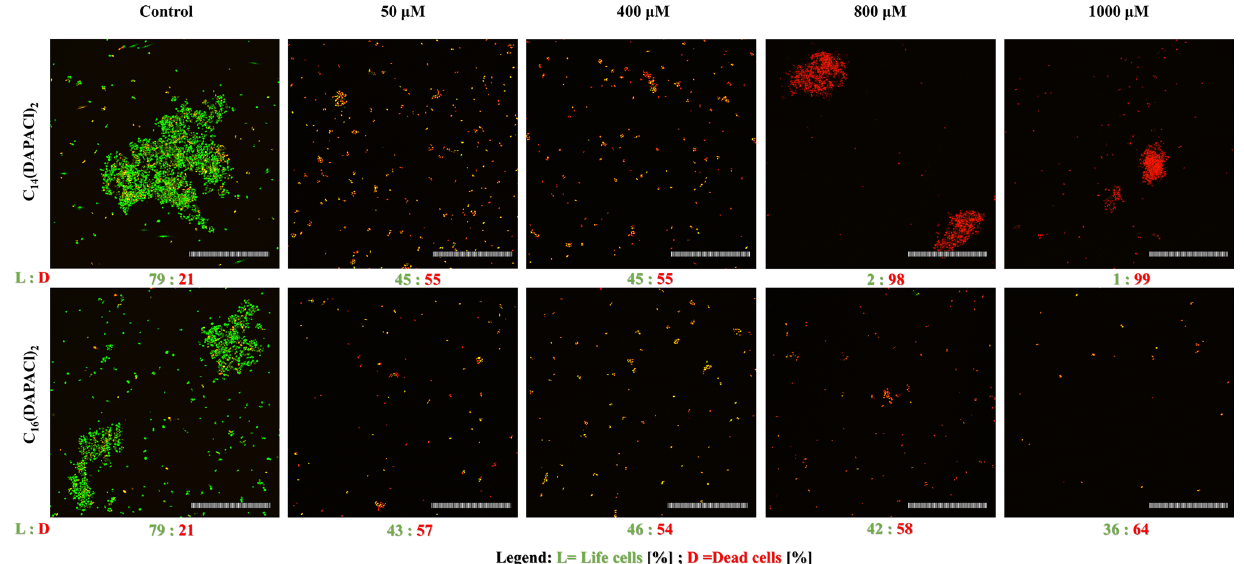
Figure 6. The impact of dimethylamine derived dicephalic cationic surfactants on biofilm viability of C. albicans on glass surface. Confocal laser scanning microscopy (CLSM): live cells (green fluorescence; Syto 9 staining) and dead cells (red fluorescence; PI staining), scale bar = 100